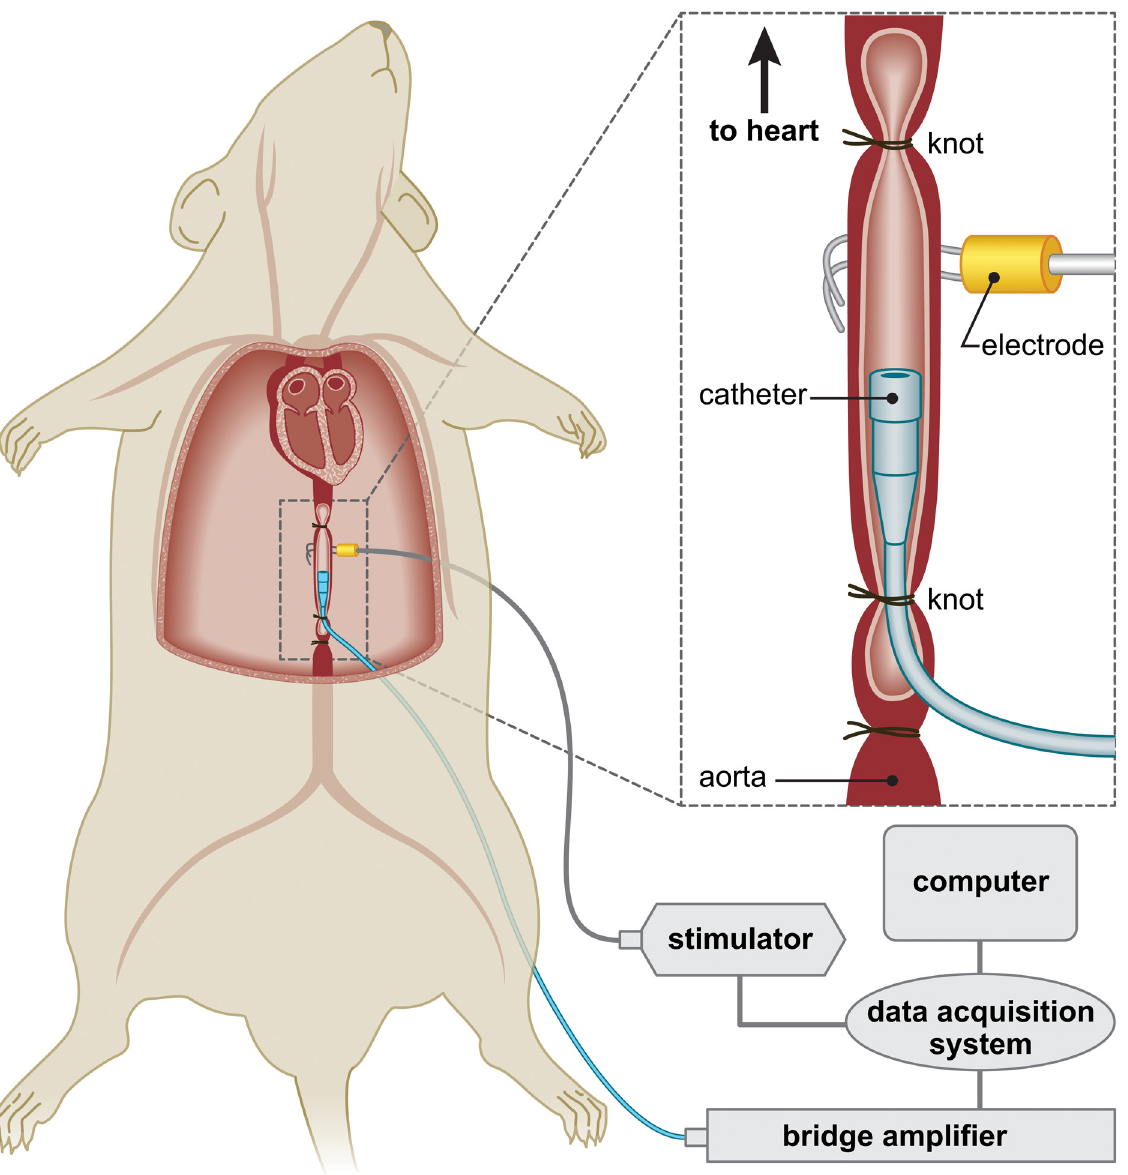
Fig 1. Schematic illustration of the set-up performing electrical stimulation of the aorta. To elicit aortic contractions, the aorta was directly stimulated with a 5s pulse train at different frequencies (pulse width, 2ms) at a 4 min inter-stimulus train using a constant voltage generator. Once two stable series of contractions were obtained at the same frequency, the aorta was exposed to different drugs by direct application into the thoracic cavity in 1ml increments. That is, an additional 1 ml of drug solution was added to the thoracic cavity. The volume of mineral oil and/or Tyrode's solution placed in the cavity was approximately 5 – 7 ml. This was followed by a series of stimulations over 5 s that were spread 4 min